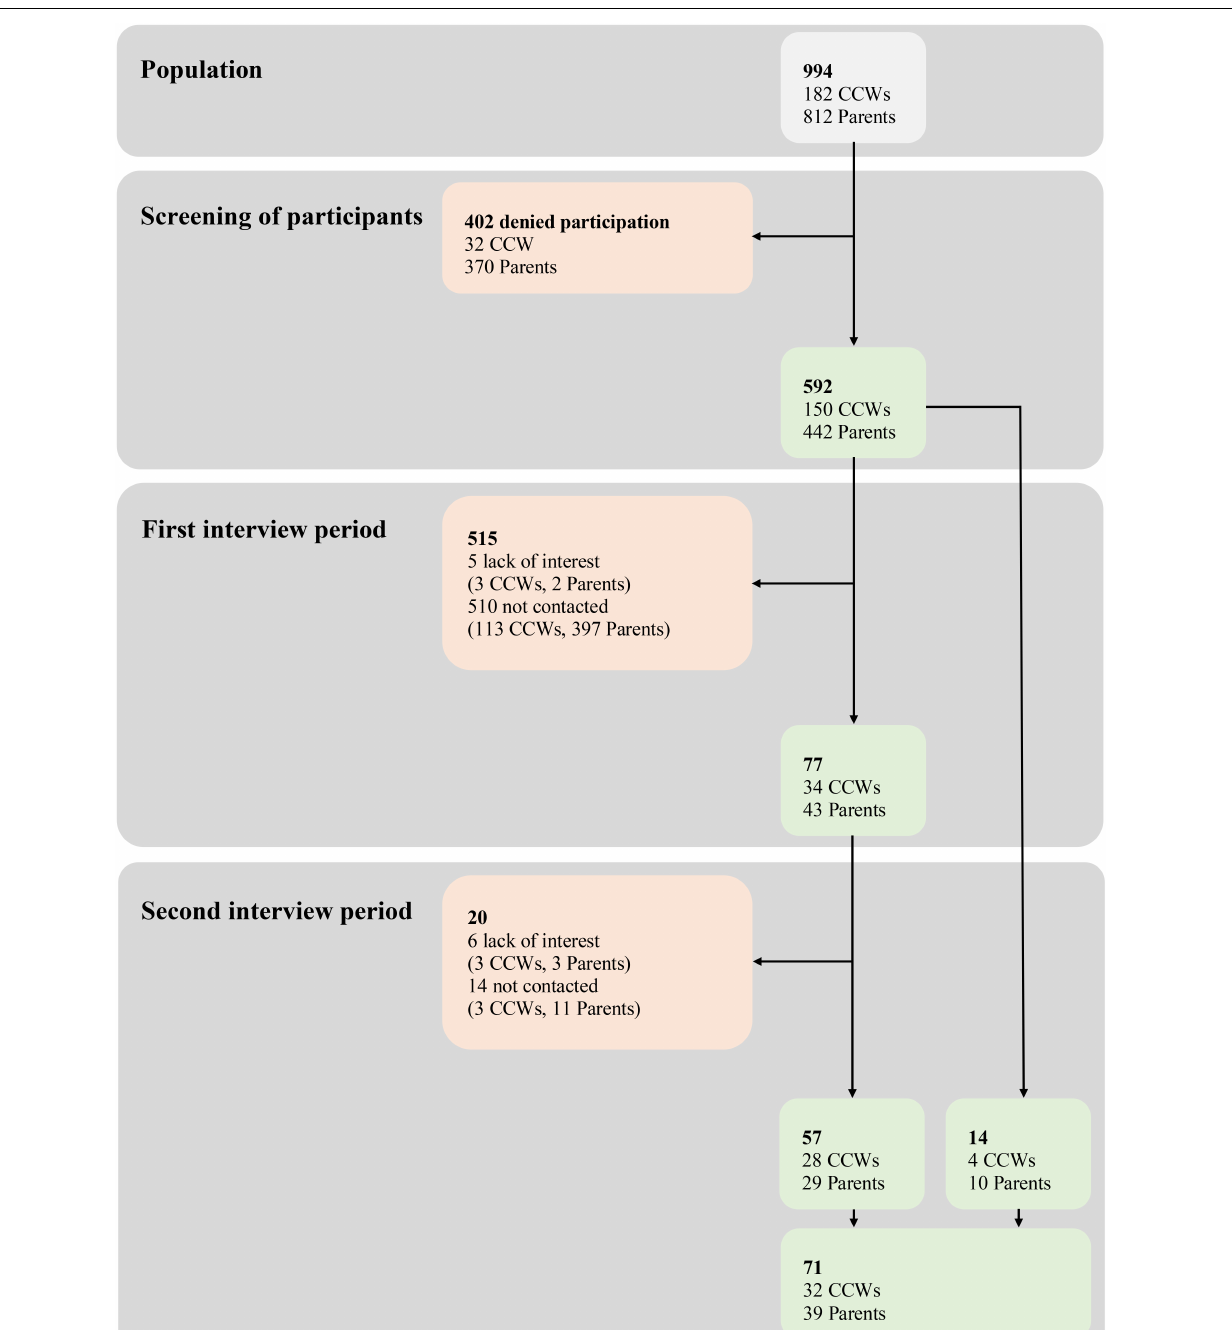
amount of information was reported, alongside with a wish for more